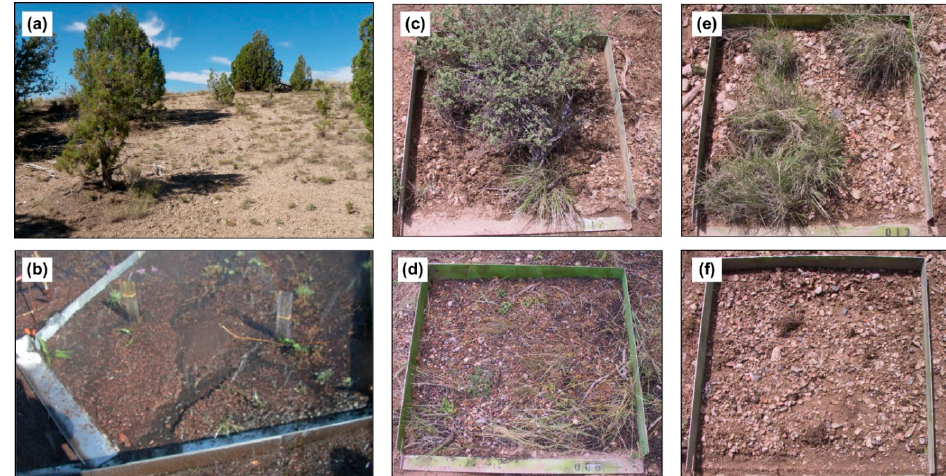
Figure 3. Photographs of a Utah juniper ( J. osteosperma [Torr.] Little) woodland showing the patchy structure of tree-covered area and bare intercanopy between trees ( a ), a bare intercanopy runoff plot with concentrated overland flow and rilling ( b ), and shrub ( c ), under tree canopy ( d ), grass covered interspace ( e ), and bare interspace ( f ) microsites. Figure modified from Pierson and Williams [135] and Miller et al. [4].